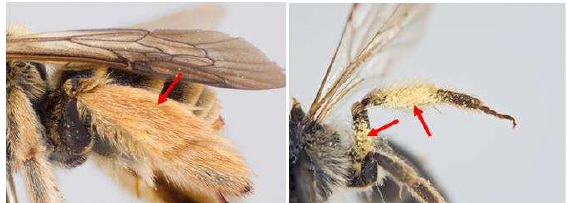
Figure 2. Detailed images taken from a user-friendly key to identify the bee families of the world (Packer and Ratti, 2009). Distinguishing characters (here: scopae on female hind legs) are described and highlighted. Further images show different forms of the character making correct identification much easier.